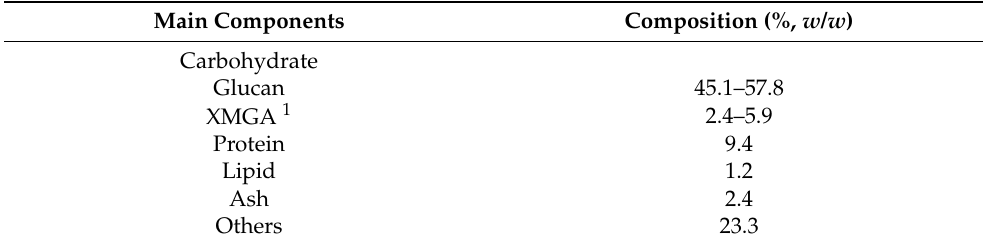
Table 2. Chemical compositions of chestnut shells